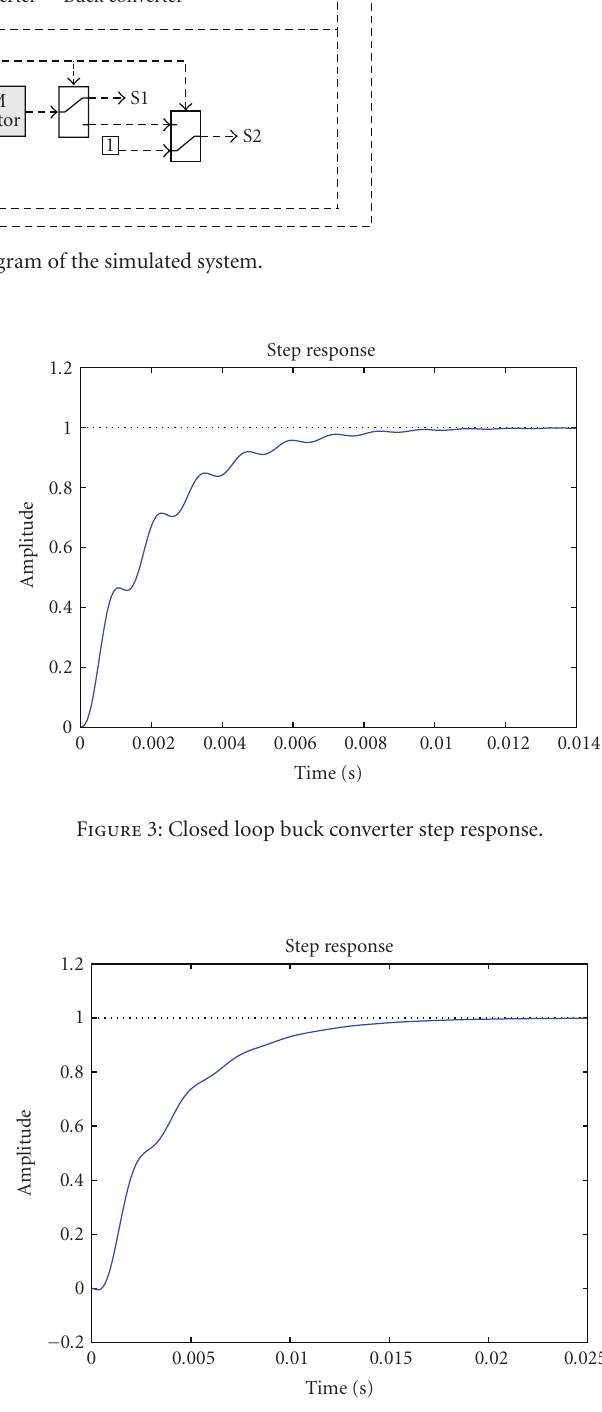
Figure 4: Closed loop boost converter step